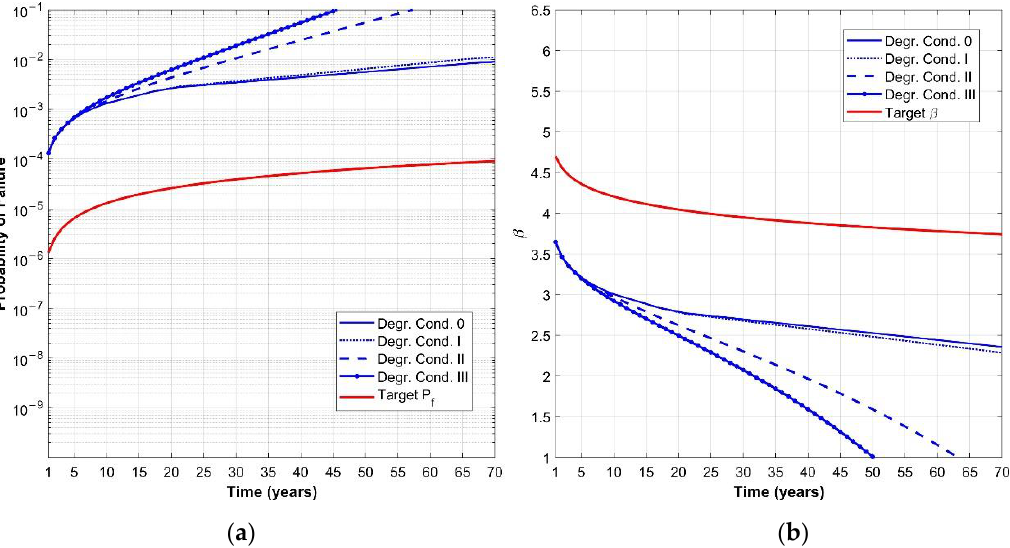
Figure 9. Time-dependent probability of failure ( a ) and reliability index 𝛽 ( b ) for residential buildings—reinforcing steel class 1 and concrete class 3, designed considering increased design loads